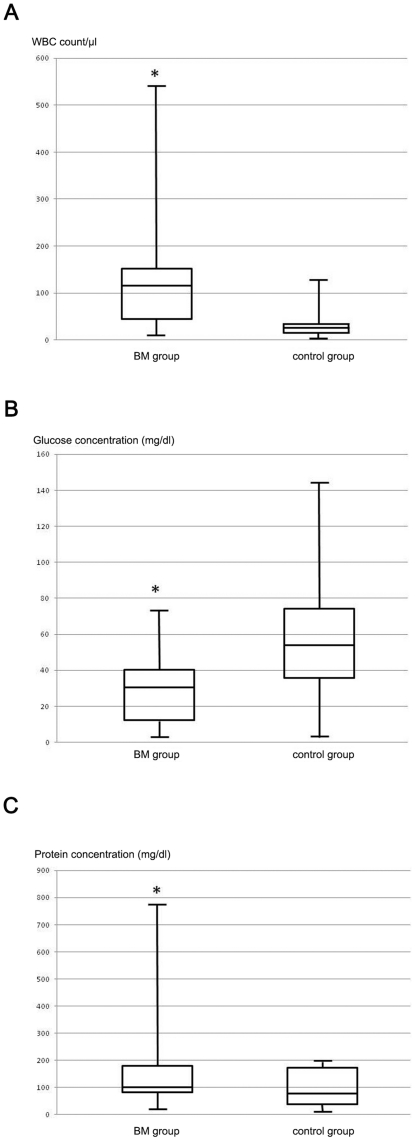
Graphical representations of minimum, maximum, mean, upper and lower quartile of examined parameters in control and BM group.a) WBC count, b) glucose concentration, c) protein concentration. For each parameter the difference of means is statistically significant. * = p<0.001.